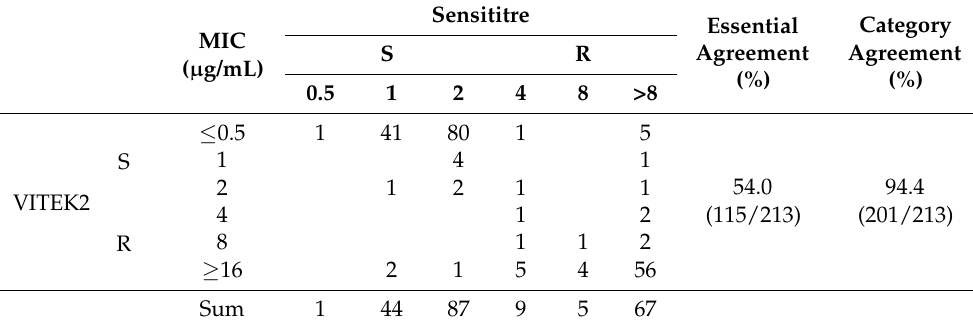
Table 4. Comparison of colistin MICs and susceptibility determined by the VITEK2 and Sensititre system. MIC